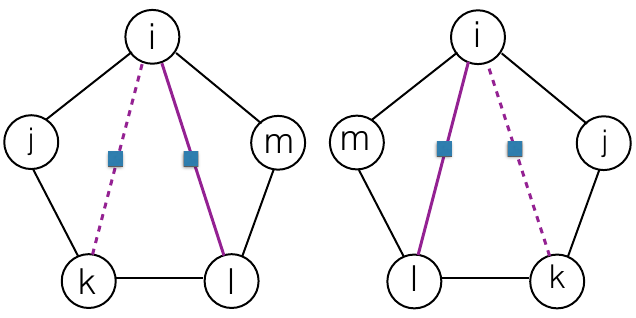
Figure 4 . The two-particle contributions the (cid:12)gure, the solid purple line has bridge length one and the dashed purple line has bridge length zero. The blue squares denote the mirror particles Notice that the two (cid:12)gures represents the same graph and they are related by a parity transformation. The equality of the graphs implies the all loop parity relation